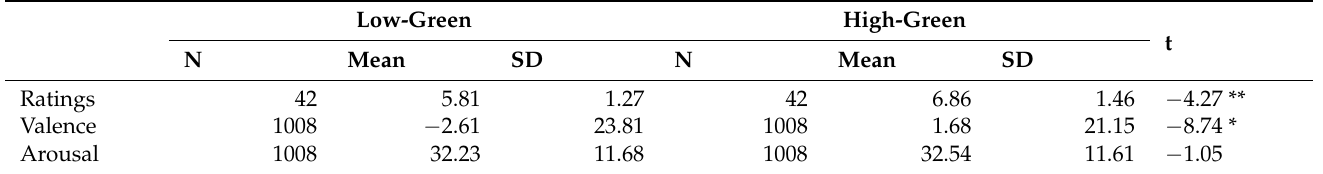
Table 6. Descriptive statistics and paired t -test results of perception data for different amounts of green.